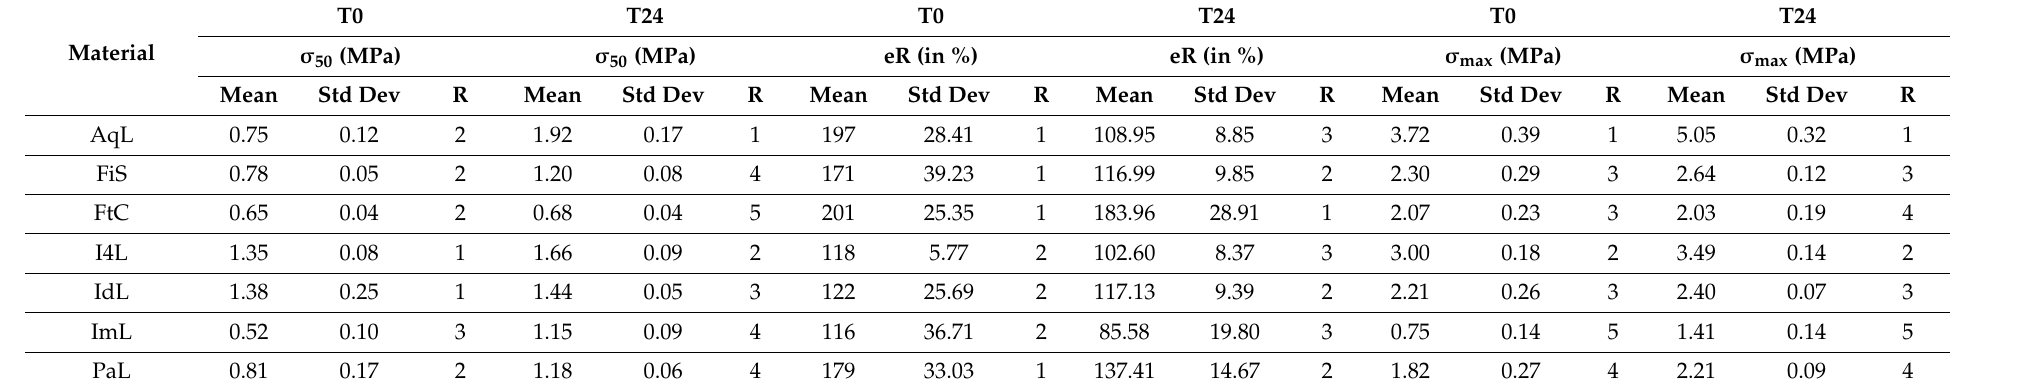
Table 5. Results from the tear strength measurements of the light-body materials at the end of the setting time (T0) and 24 h later (T24). Ranks had a statistical difference within each time